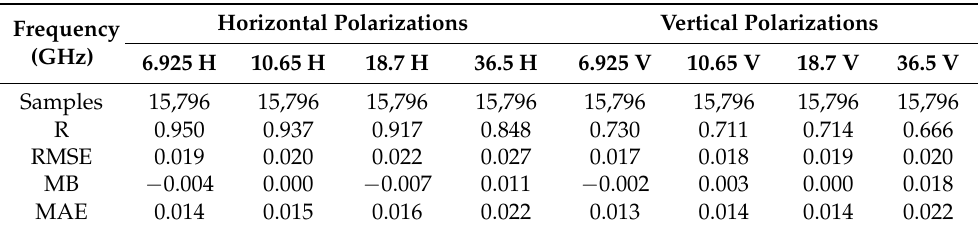
Table 4. Statistical metrics of comparison of MLSE derived in our study with those from Norouzi_MLSE in China during summer (JJA) in 2003.